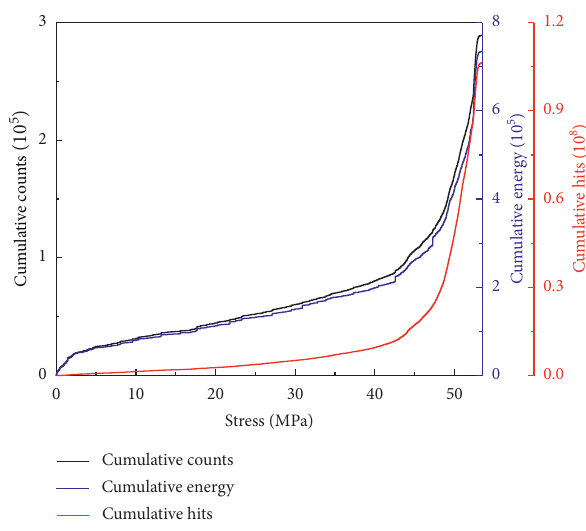
Figure 8: Relation between cumulative counts, cumulative energy, cumulative events, and